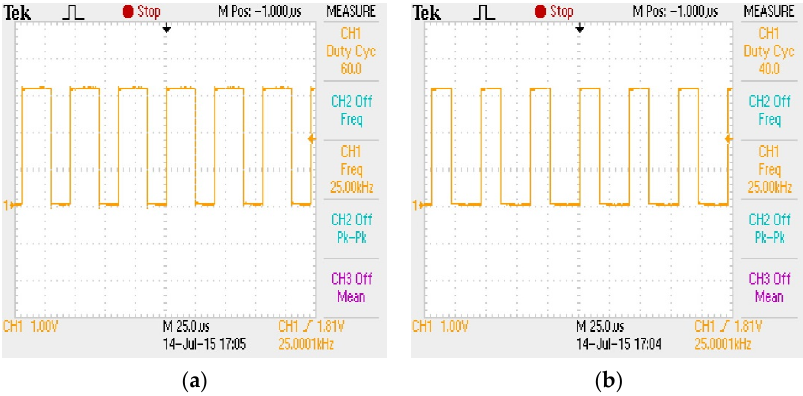
Figure 11. The duty cycle for a reference signal value of 0.6 by defining the third and fourth event managers as ( a ) ”clear” and “set” and ( b ) “set” and “clear”.